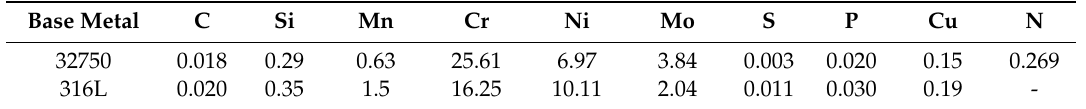
Table 1. Chemical composition of the base metals (wt.%).